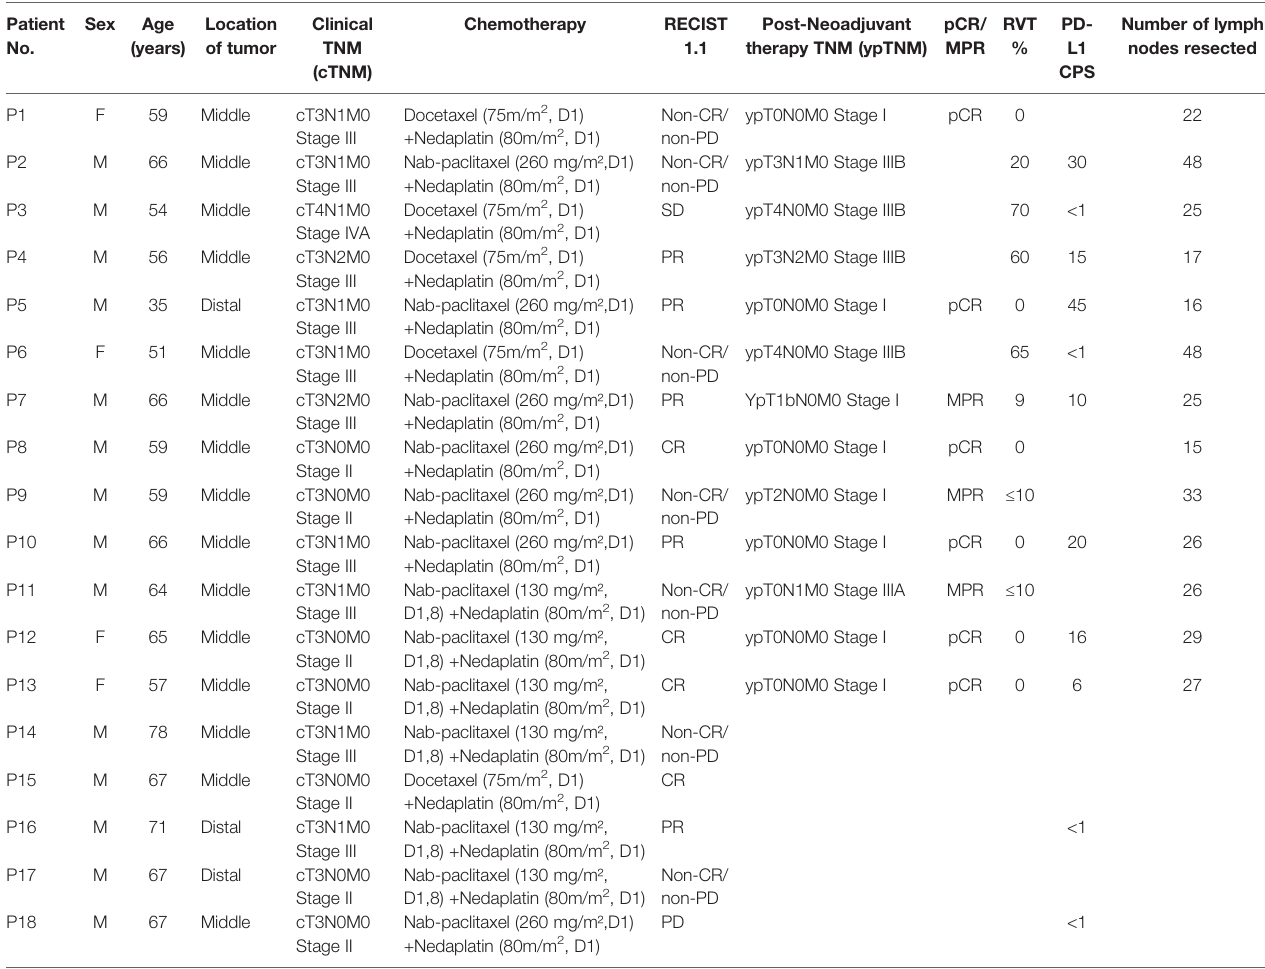
TABLE 1 | All detailed data about patients. Patient